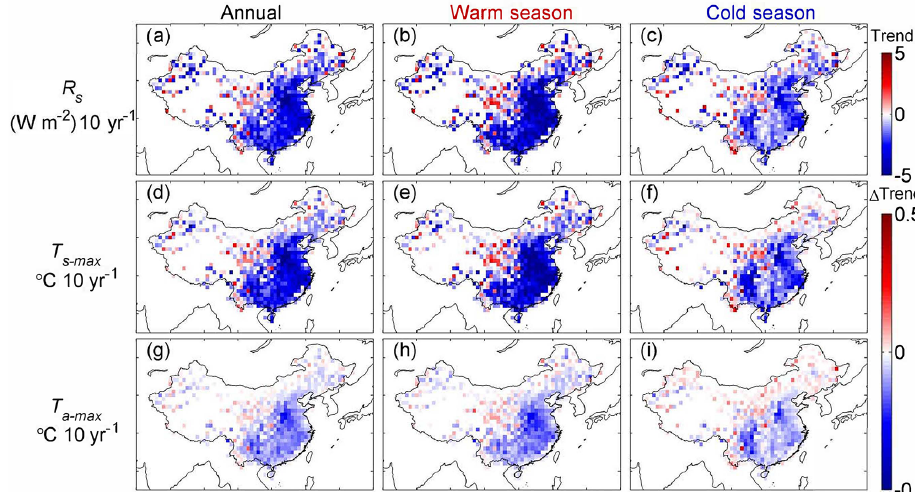
Figure 5. Maps of the trends in surface solar radiation ( R s , (a–c) ) and their effect on the warming rates of daily maximum land surface temperature ( T s-max , (d–f) ) and daily maximum air temperature ( T a-max , (g–i) ). The first line (a–c) is the trends of R s from 1960 to 2003; the second line (d–f) and the third line (g–i) are the trend changes caused by secular variations in R s on T s-max and T a-max . Equation (1) was used to strip away the effect of R s on temperatures, and we calculated the trend difference ( (cid:49) Trend, (d–i) ) between the time series of temperatures before and after adjusting for the effect of R s . Finally, the effect of R s on the trends of T s-max and T a-max was quantified and analyzed (Sect. 3.2.1).